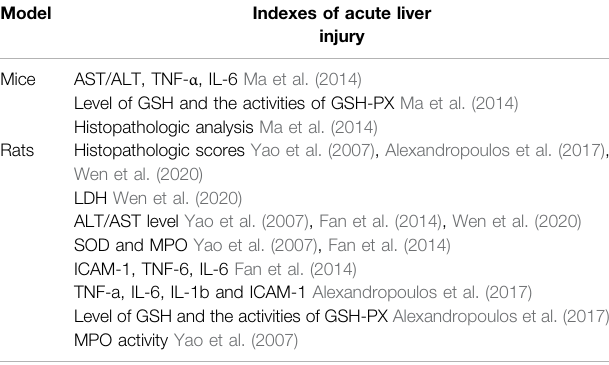
TABLE 1 | Indexes of acute liver injury in different animal